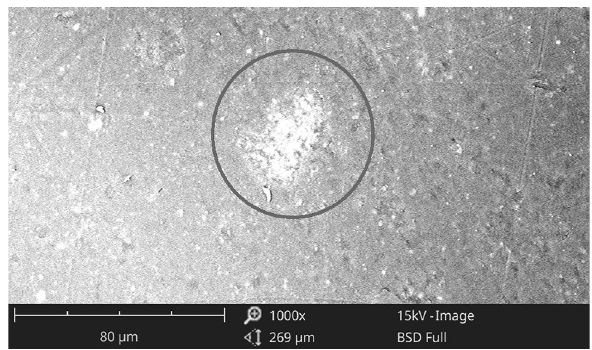
Fig. 3 SEM image of a Cloisite 20A nanoclay